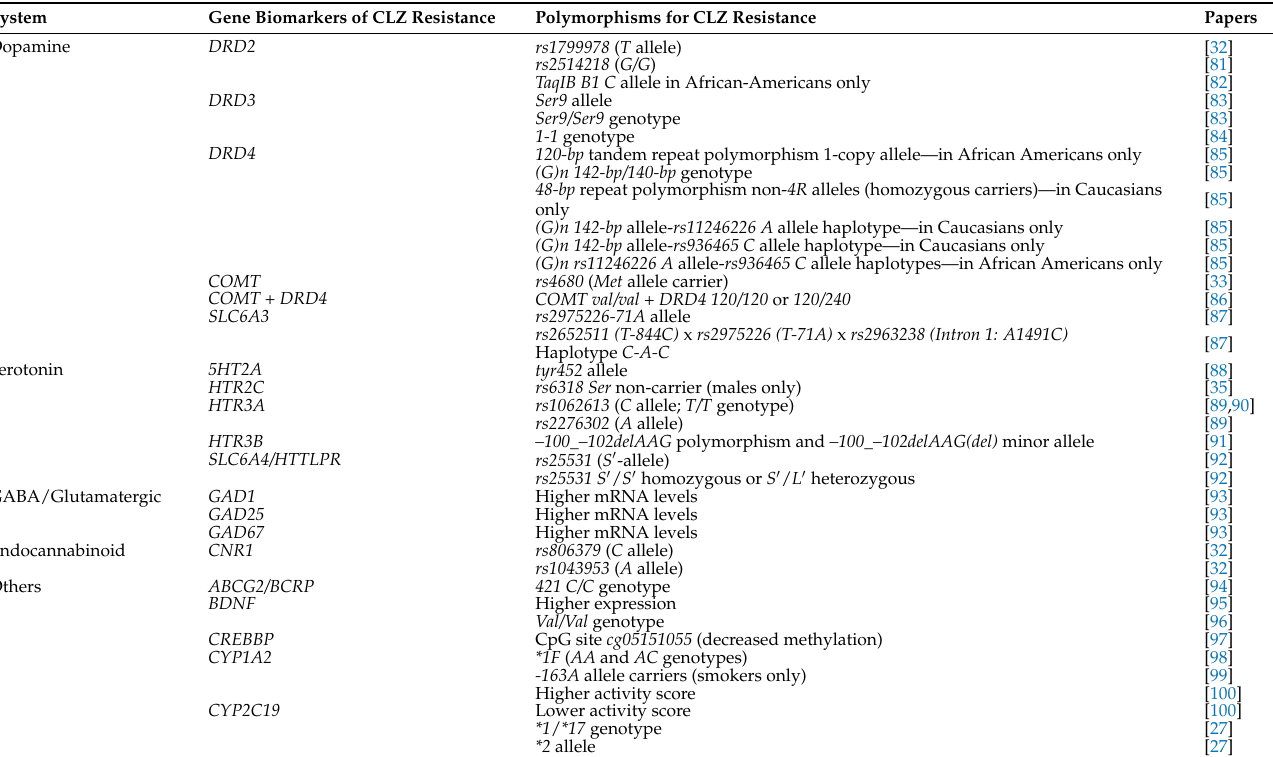
Table 2. Risk genes/polymorphisms for Clozapine